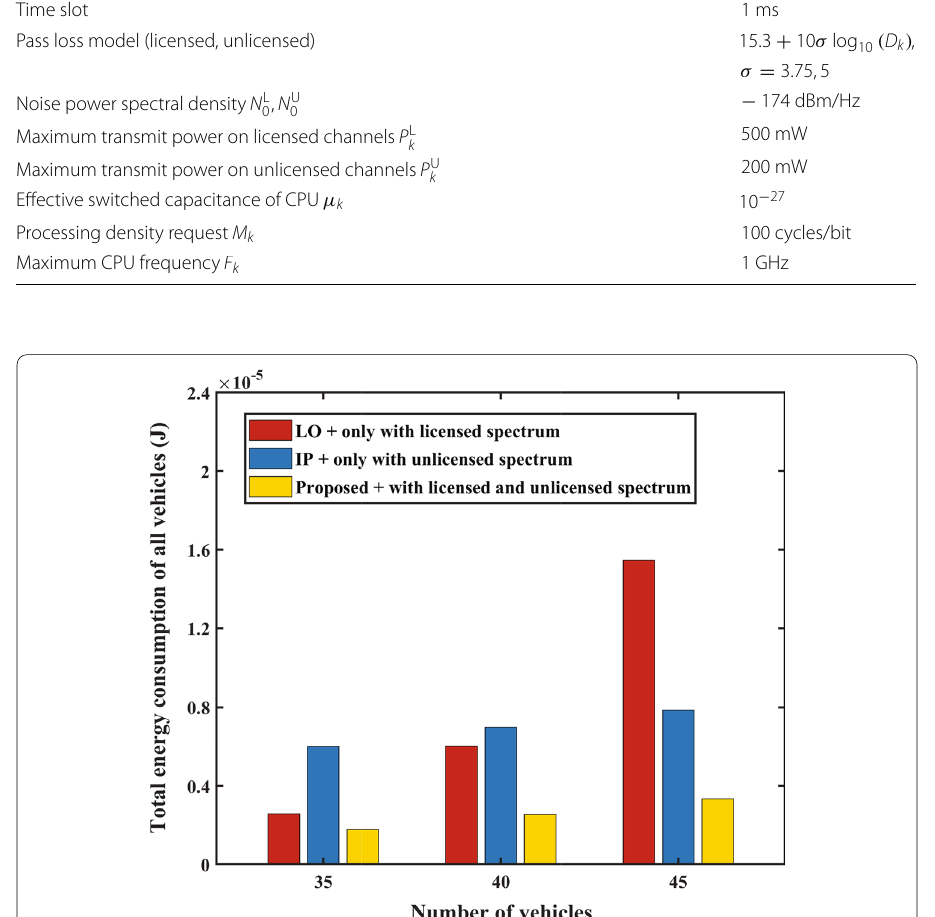
20 MHz, S k 0.5, and = =